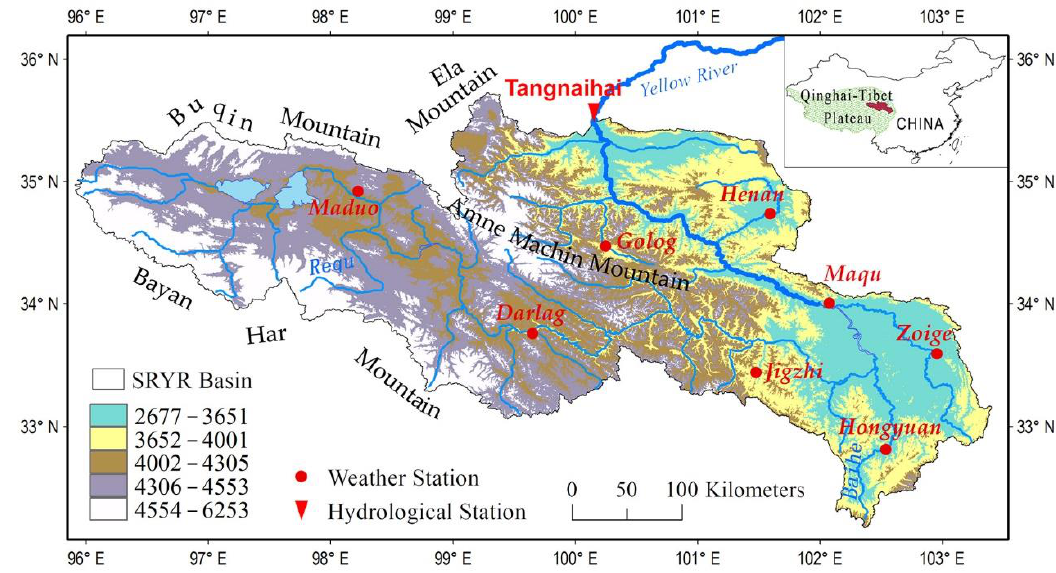
Figure 1. The source region of the Yellow River.